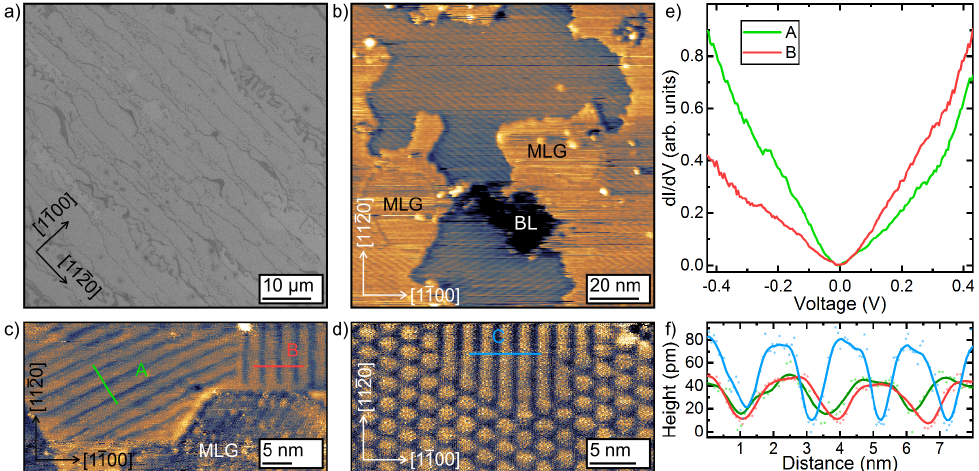
Figure 3. ( a ) Large scale SEM image of the intercalated area. The dark contrast refers to residual (insulating) BL areas. ( b – d ) STM images of various phases after intercalation of Pb revealing both striped and bubble-like modulations (( b ) − 0.5 V, 1 nA; ( c ) − 0.2 V, 0.02 nA; ( d ) − 1 V, 0.2 nA). MLG and BL label non-intercalated monolayer graphene and buffer layer areas, respectively. ( e ) STS spectra on two different striped phases (set point − 0.5 V, 0.5 nA). The measurements were performed at LN 2 temperature. ( f ) Height profiles across various striped